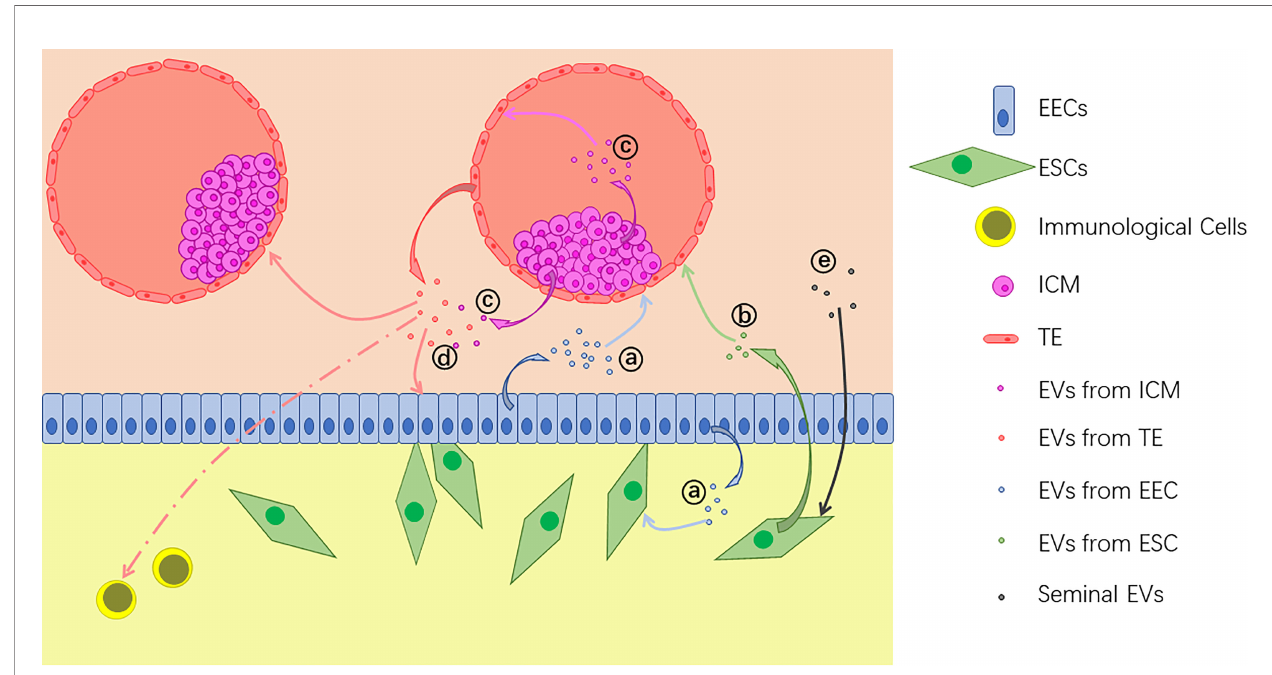
FIGURE 2 | Extracellular vesicles (EVs) are released by different kinds of cells during implantation: (A) EVs from endometrial epithelial cells (EECs) act on the embryo and uterine fi broblasts; (B) EVs from endometrium stromal cells (ESCs) also act on the embryo; (C) EVs from the inner cell mass (ICM) act on the trophectoderm (TE) and some of them are transferred out of the blastocyst; (D) EVs from the embryo, including both TE and ICM, act on EECs, other embryos and immunological cells; (E) Seminal EVs act on